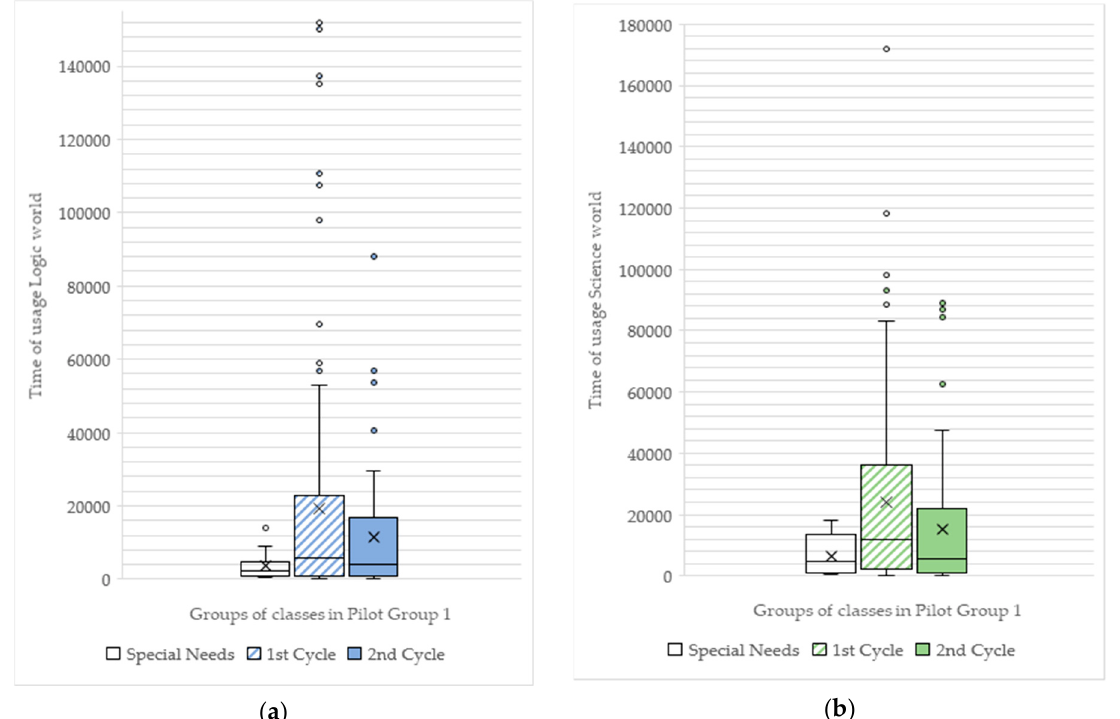
Figure 4. Descriptive statistic representation of significant results with one-way ANOVA. ( a ) Figure showing major results for ‘time of usage’ among class groups in the world Logic. ( b ) Figure showing major results for ‘time of usage’ among class groups in the world Science.